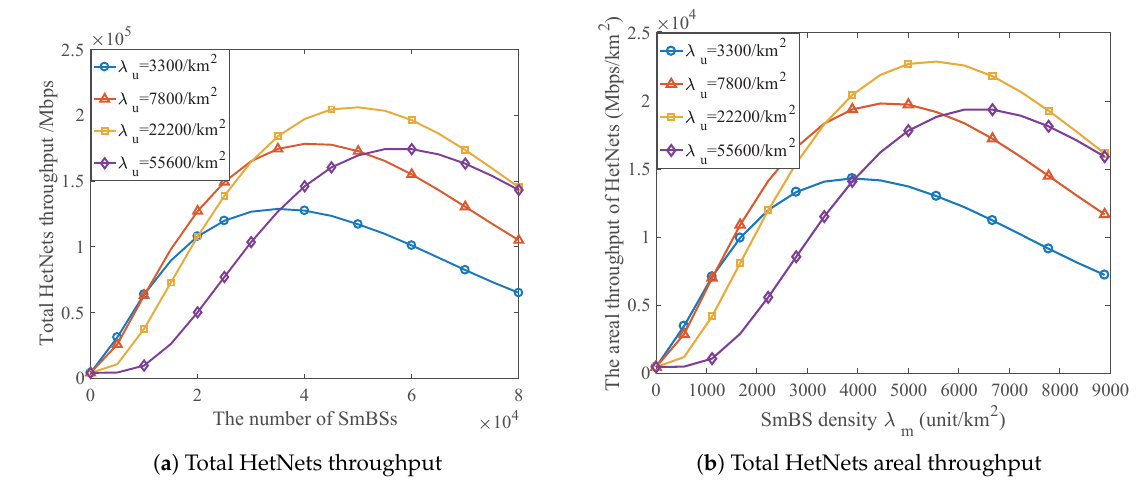
Figure 7. The impact of SmBS density on HetNets throughput. Network area = 9 km 2 , P m = 60 mW. Figure 8 has compared the performance of the optimal deployment and other suboptimal ones.